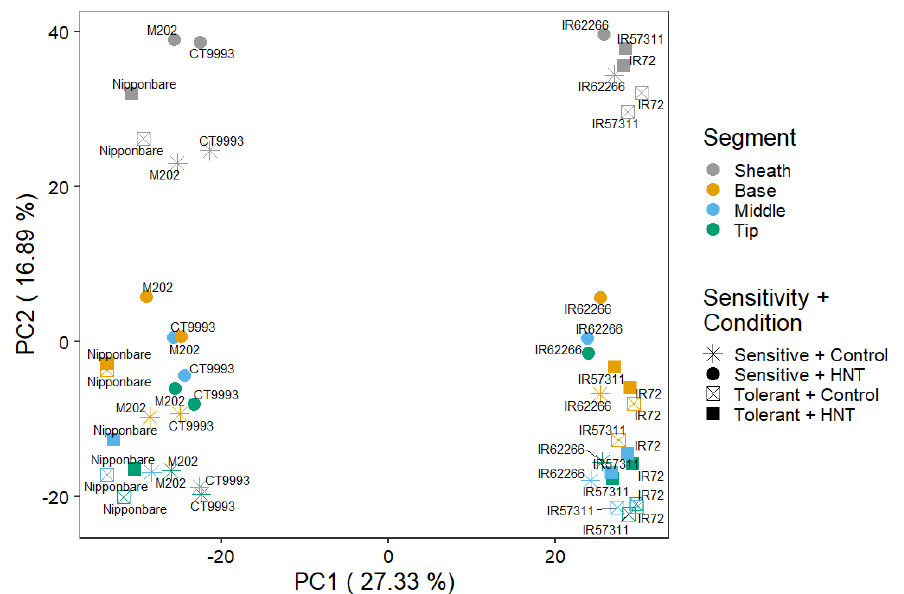
Figure 6. Principle component analysis of RNA-Seq raw counts from samples of all four rice leaf segments exposed to control and HNT conditions.